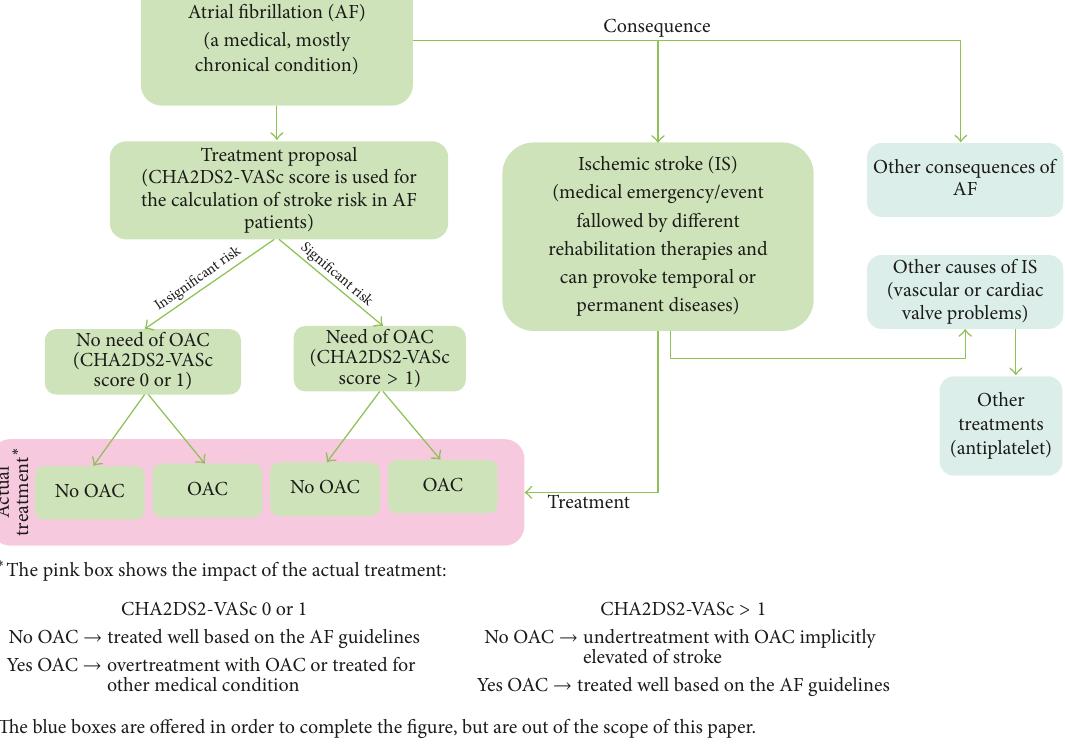
Figure 1: Healthcare path of AF medical